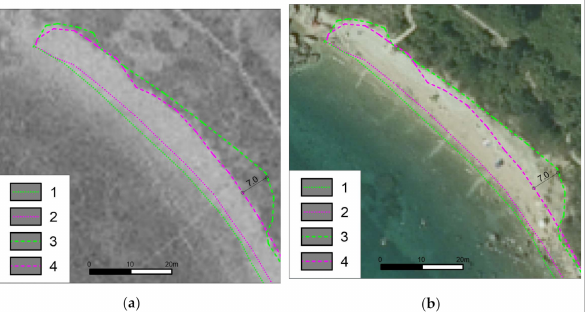
Figure 12. Ortho photo map (from 1966 ( a ) and 2014 ( b )) showing considerable coastal changes from 1966 to 2014: 1—coastline 2004; 2—coastline 1966; 3—cliff line 2004; 4—cliff line 1966.